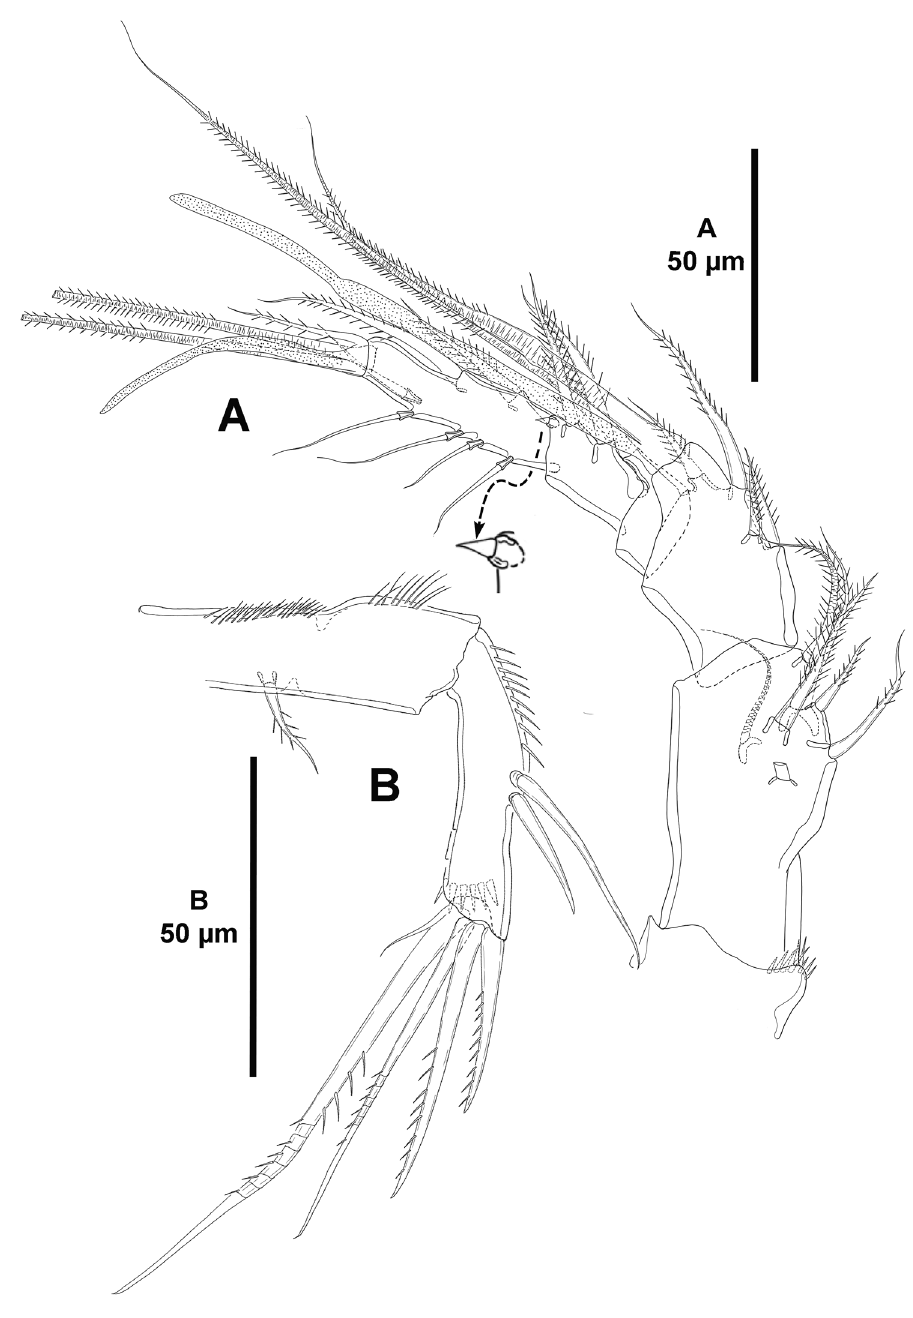
Figure 4. Eurycletodes paraephippiger sp. n., female holotype. A antennule B